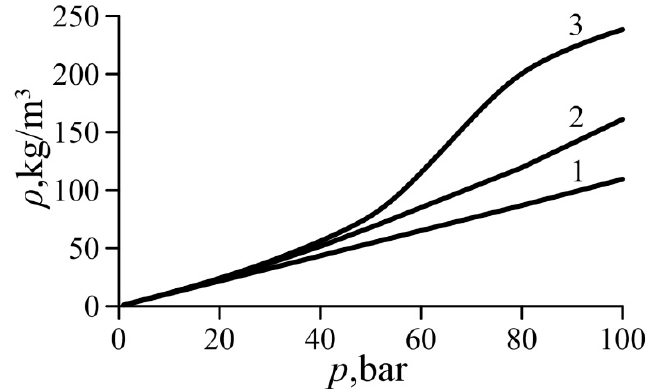
Figure 2. Gas density variation with pressure for ethylene. 1—Equation (2) (ideal gas), 2—Equation (22) (simplified van der Waals equation, present study), 3—Equation (5) (van der Waals equation).